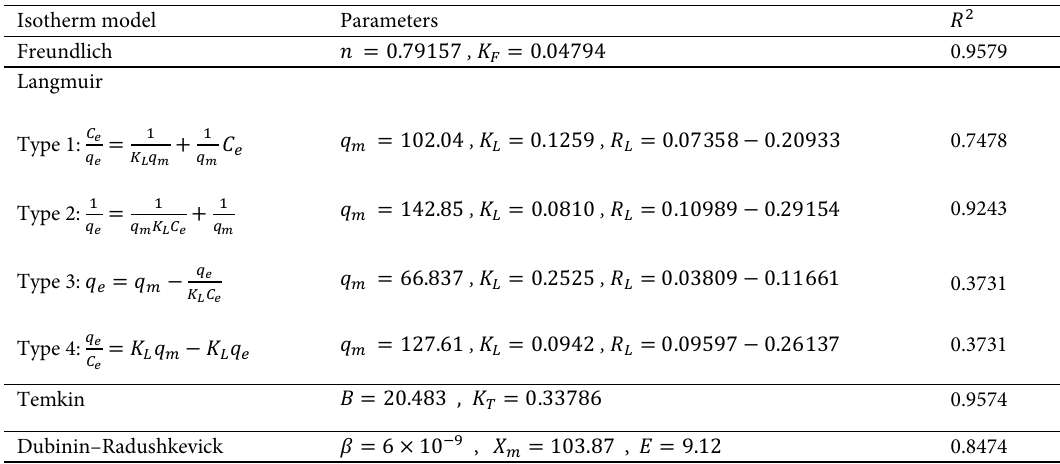
Table 2 Isotherm constants for Amido Black 10B dye adsorption. Table 2. Isotherm constants for Amido Black 10B dye